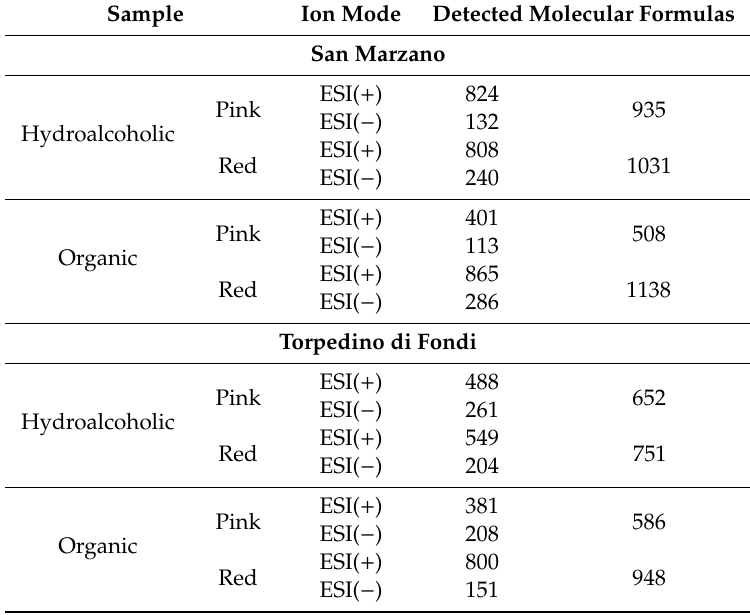
Table 5. Number of chemical formulas detected in hydroalcoholic and organic extracts of pink and red SM and TF by ESI FT-ICR